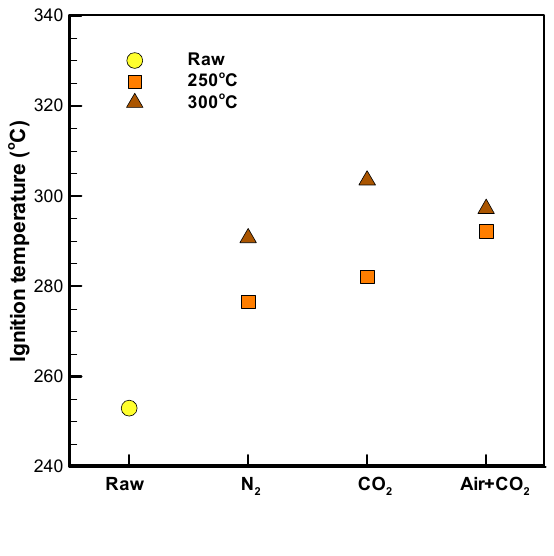
Figure 11. Profiles of ignition temperature of raw and torrefied corncob